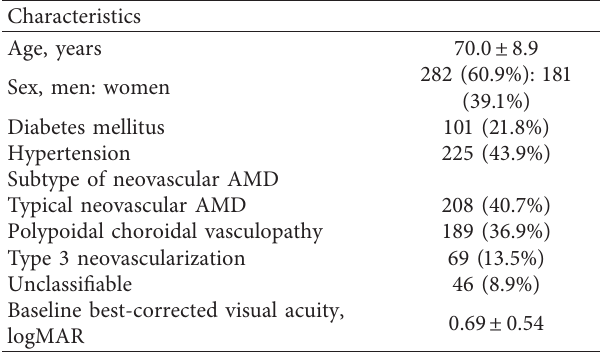
Table 4: Demographic information of 463 patients (512